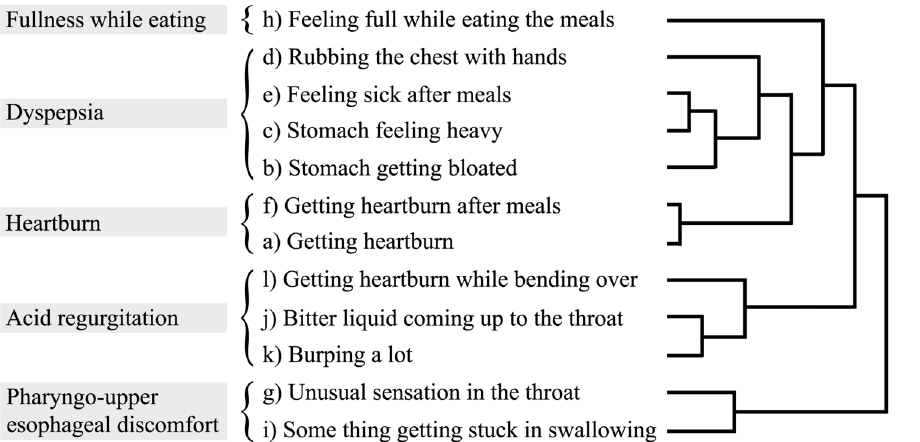
Figure 3. A dendrogram of the 12 upper GI symptoms based on the hierarchical cluster analysis (Ward’s method) of the 18,097 digestive drug-free subjects. Our proposed five categorization of 12 upper GI symptoms is also denoted.